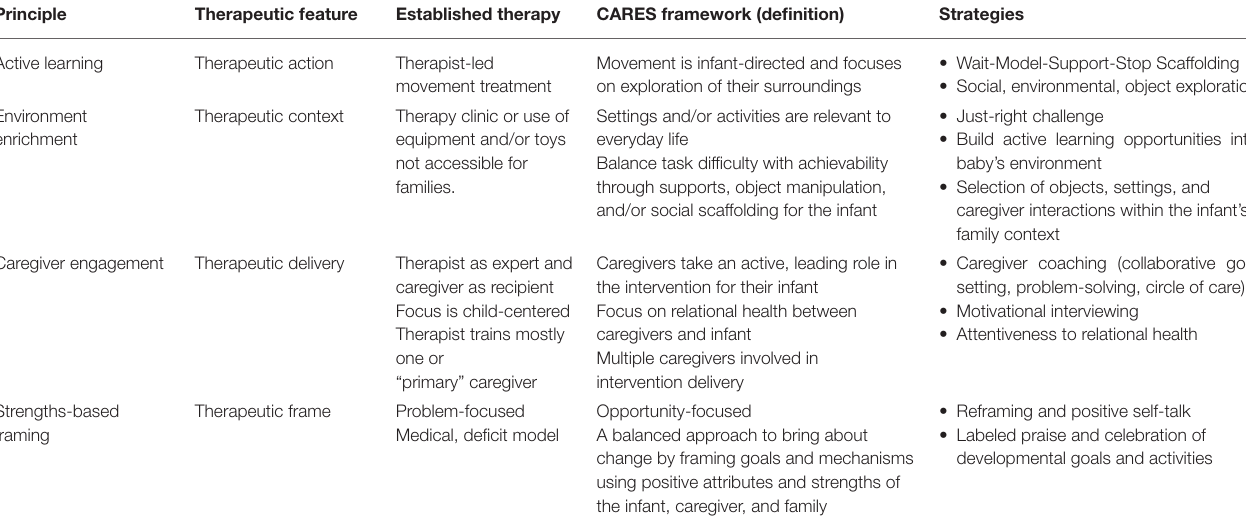
TABLE 1 | Heuristic comparison of CARES framework compared to commonly established